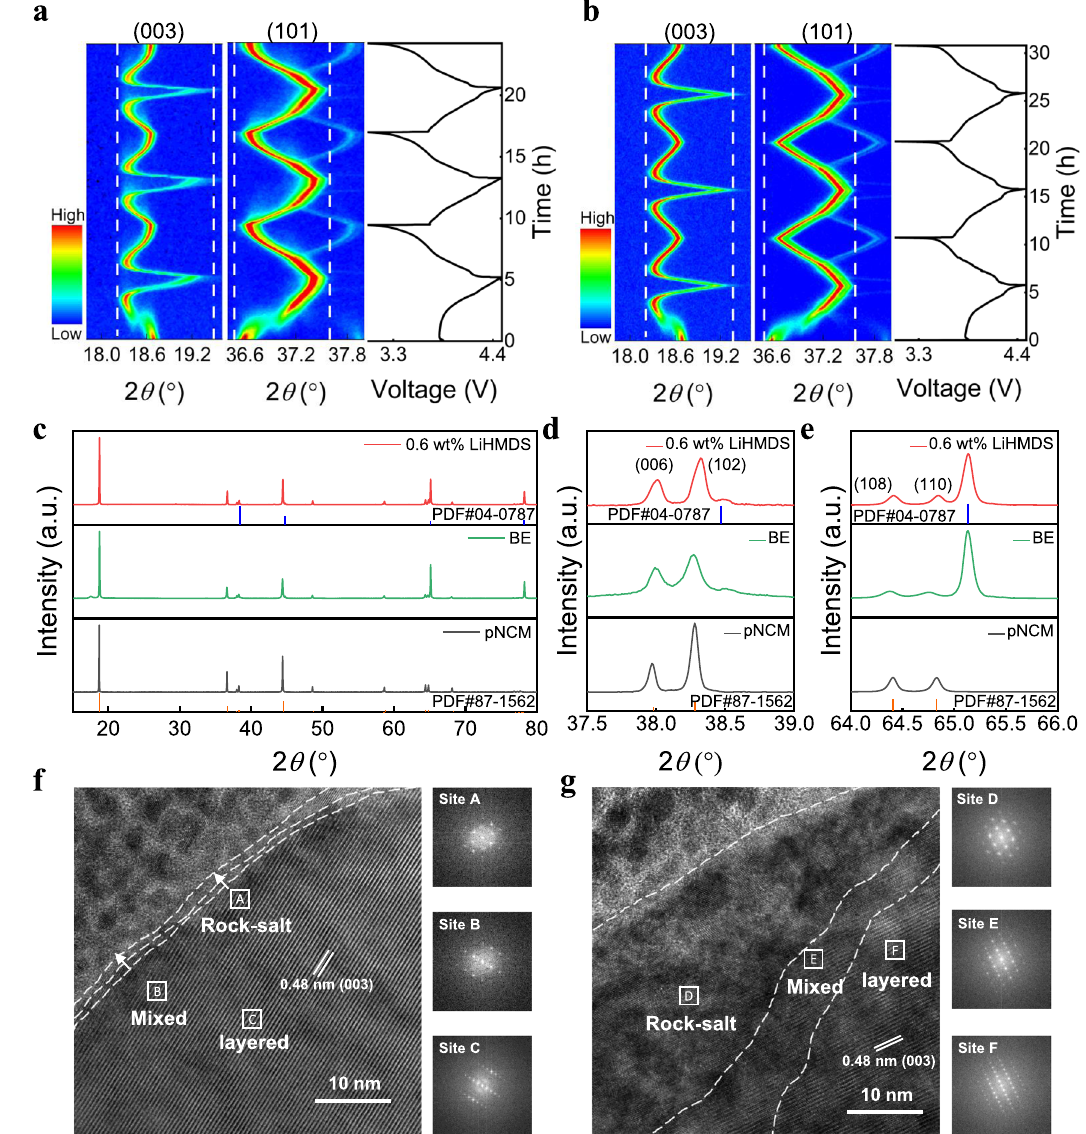
Fig. 3 | Structure characterizations of NCM811 cathode. Operando XRD char- acterization for NCM811 cathode during the initial three charge-discharge cycles using a BEand b BEwithLiHMDS.thecharging/dischargingcurrentwere36mAg − 1 / 36mAg − 1 . c – e Exsitu XRD measurements of NCM811 cathodebeforeand after 100 cycles in BE and BE with LiHMDS at 60°C, the charging/discharging current were